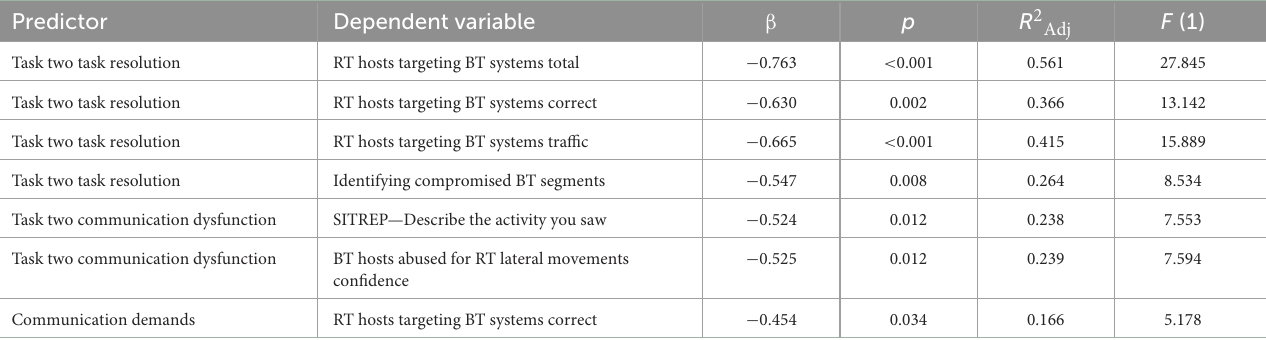
TABLE 5 Linear regressions ( N =